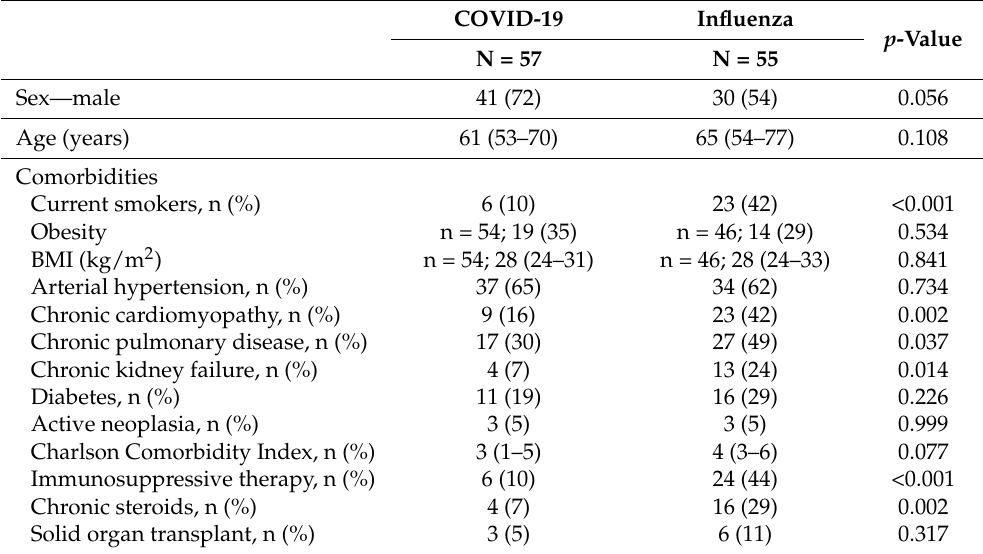
Table 1. Baseline patient